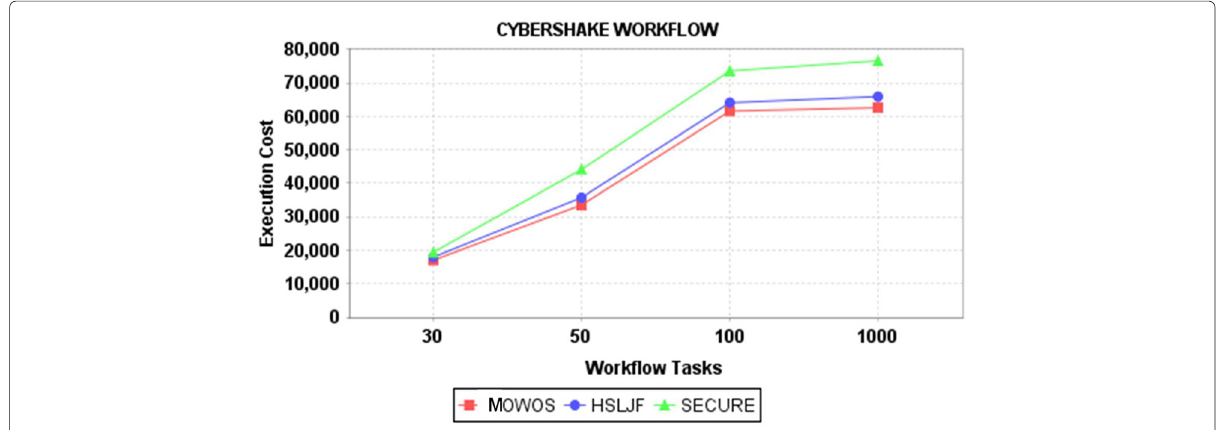
Fig. 6 Comparison of execution cost using CyberShake